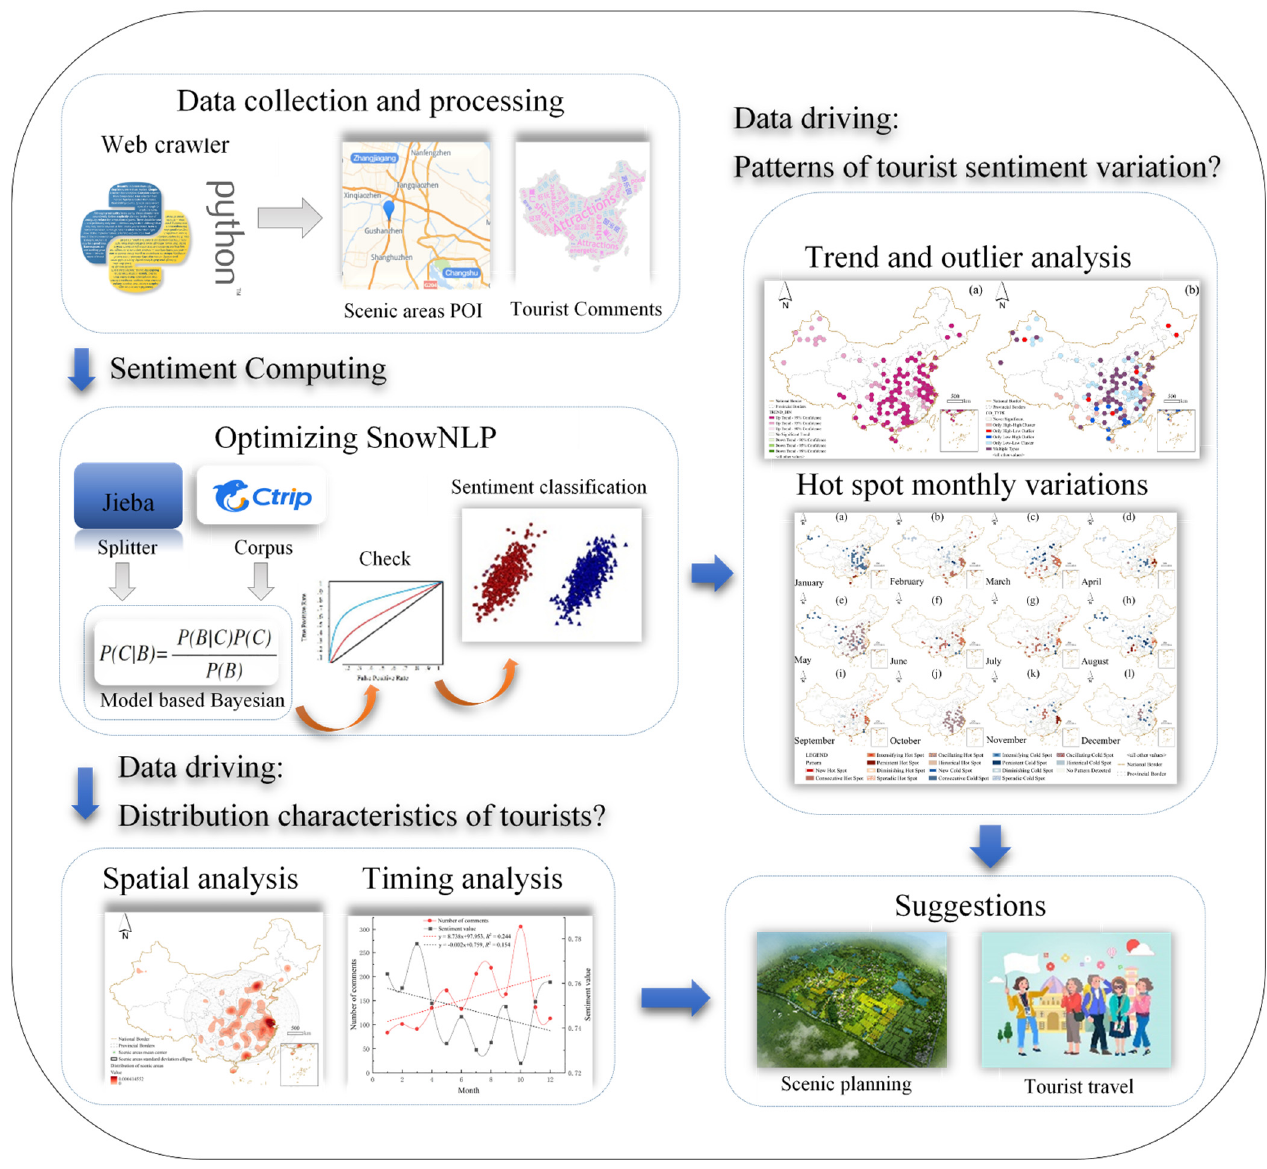
Figure 2. Research